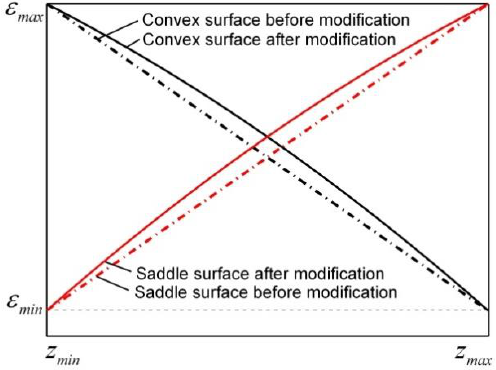
Figure 4. Relationship between longitudinal strain and height coordinate.